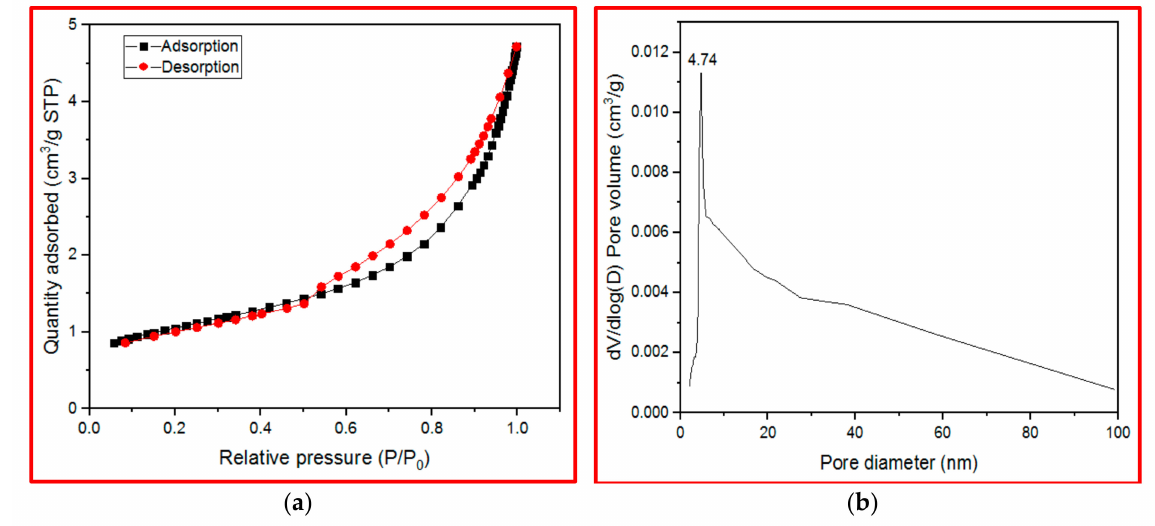
Figure 5. Plots of ( a ) N 2 adsorption / desorption isotherms and ( b ) pore-size distribution for CPP.